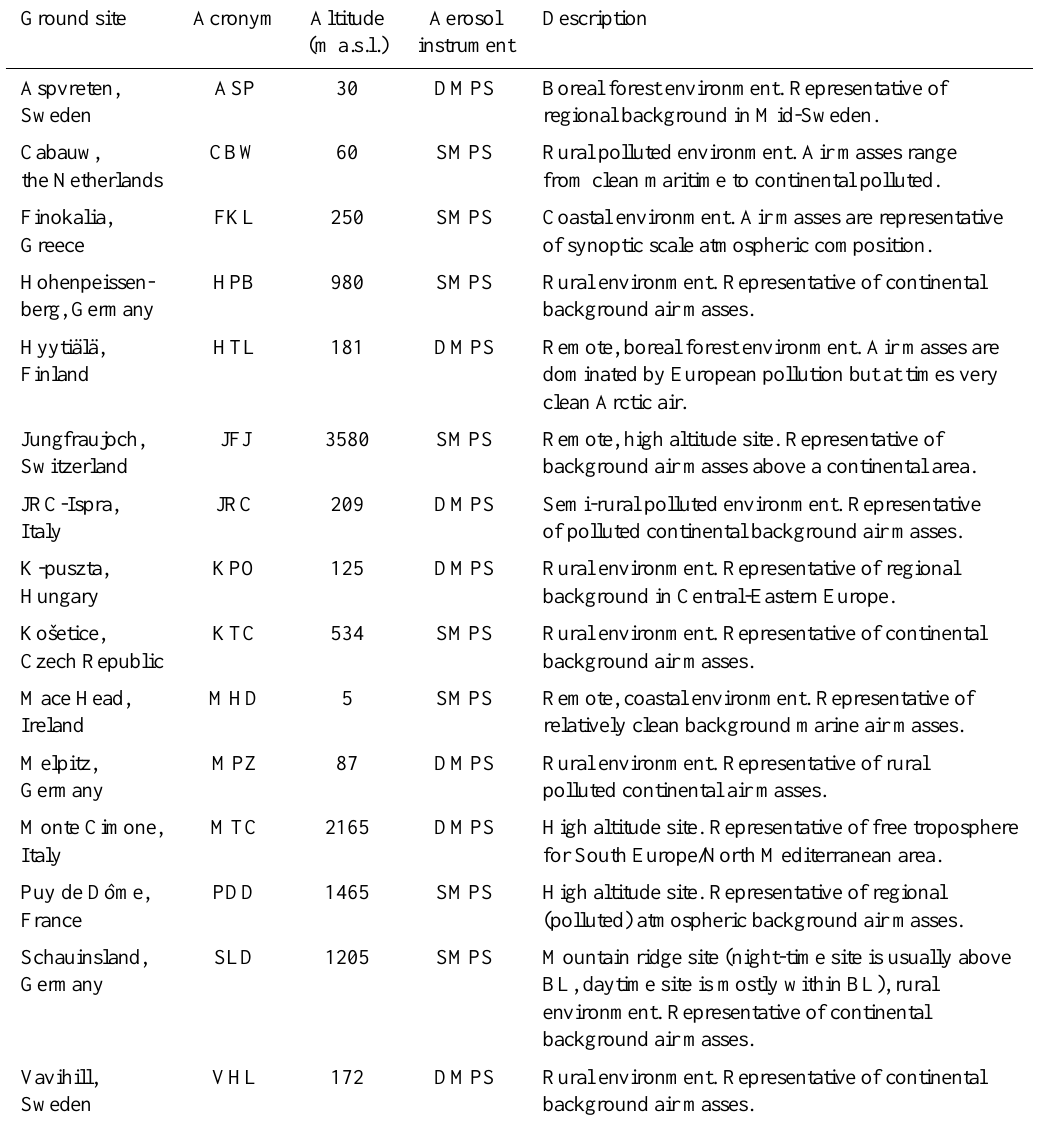
Table 1. Summary of surface observation sites used in this study. Site descriptions are based on the information provided by EUSAAR (www.eusaar.net) and on the site-categorisation of Henne et al.